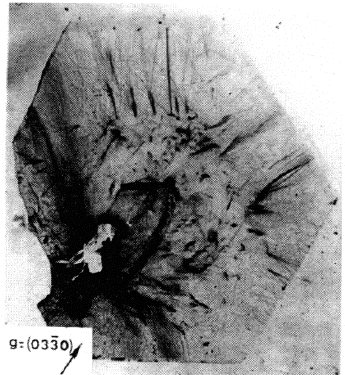
Figure 2. Dislocations in α -Al 2 O 3 crystal.